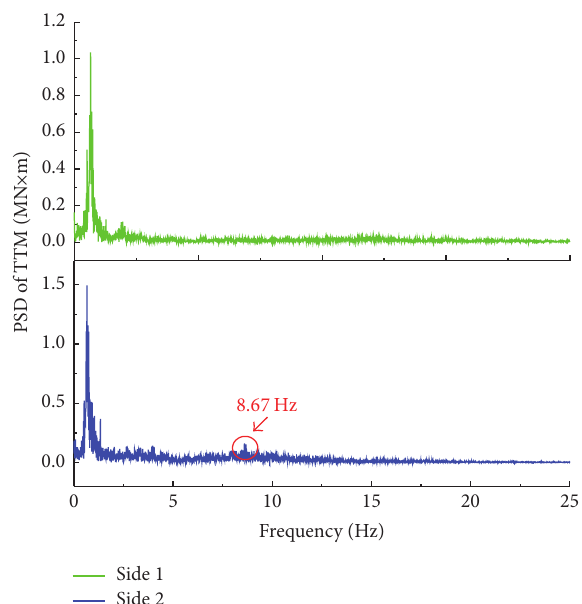
Figure 37: Power spectral density functions of TTM.